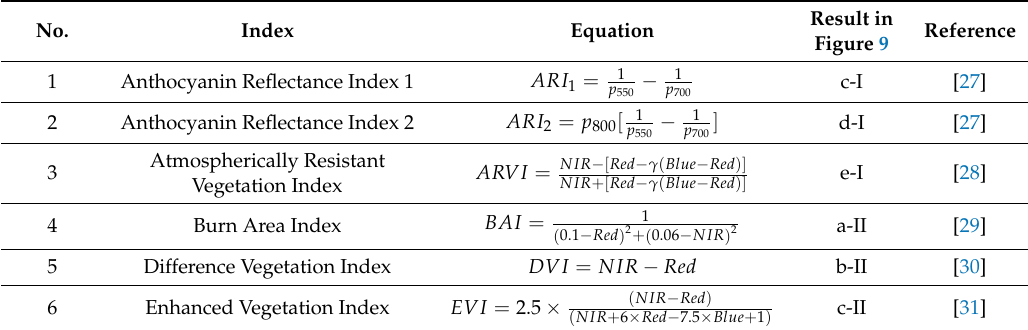
Table 2. Indices applied for the detection of looted marks in the WorldView-2 image. Promising indices are